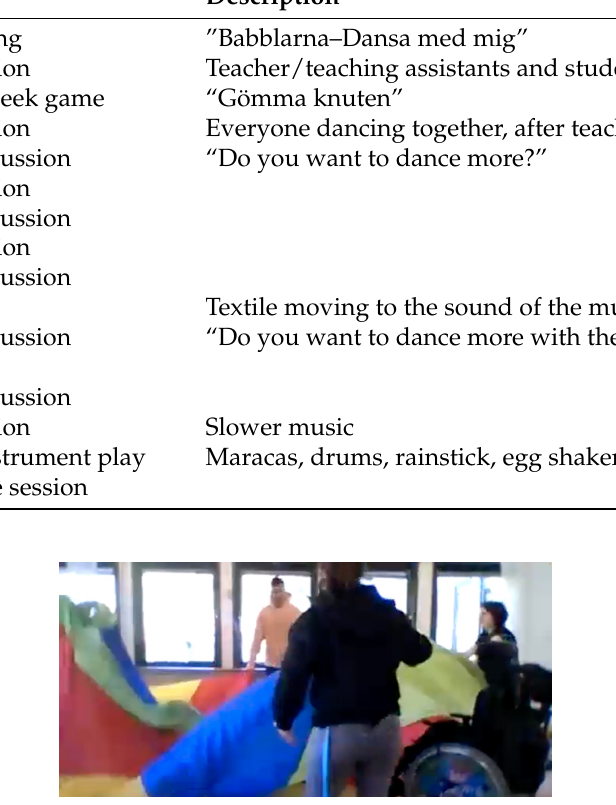
Figure 8. The “parachute” textile used during the music/dance lesson, held by the teacher and teaching assistants. All students are sitting underneath the textile in this